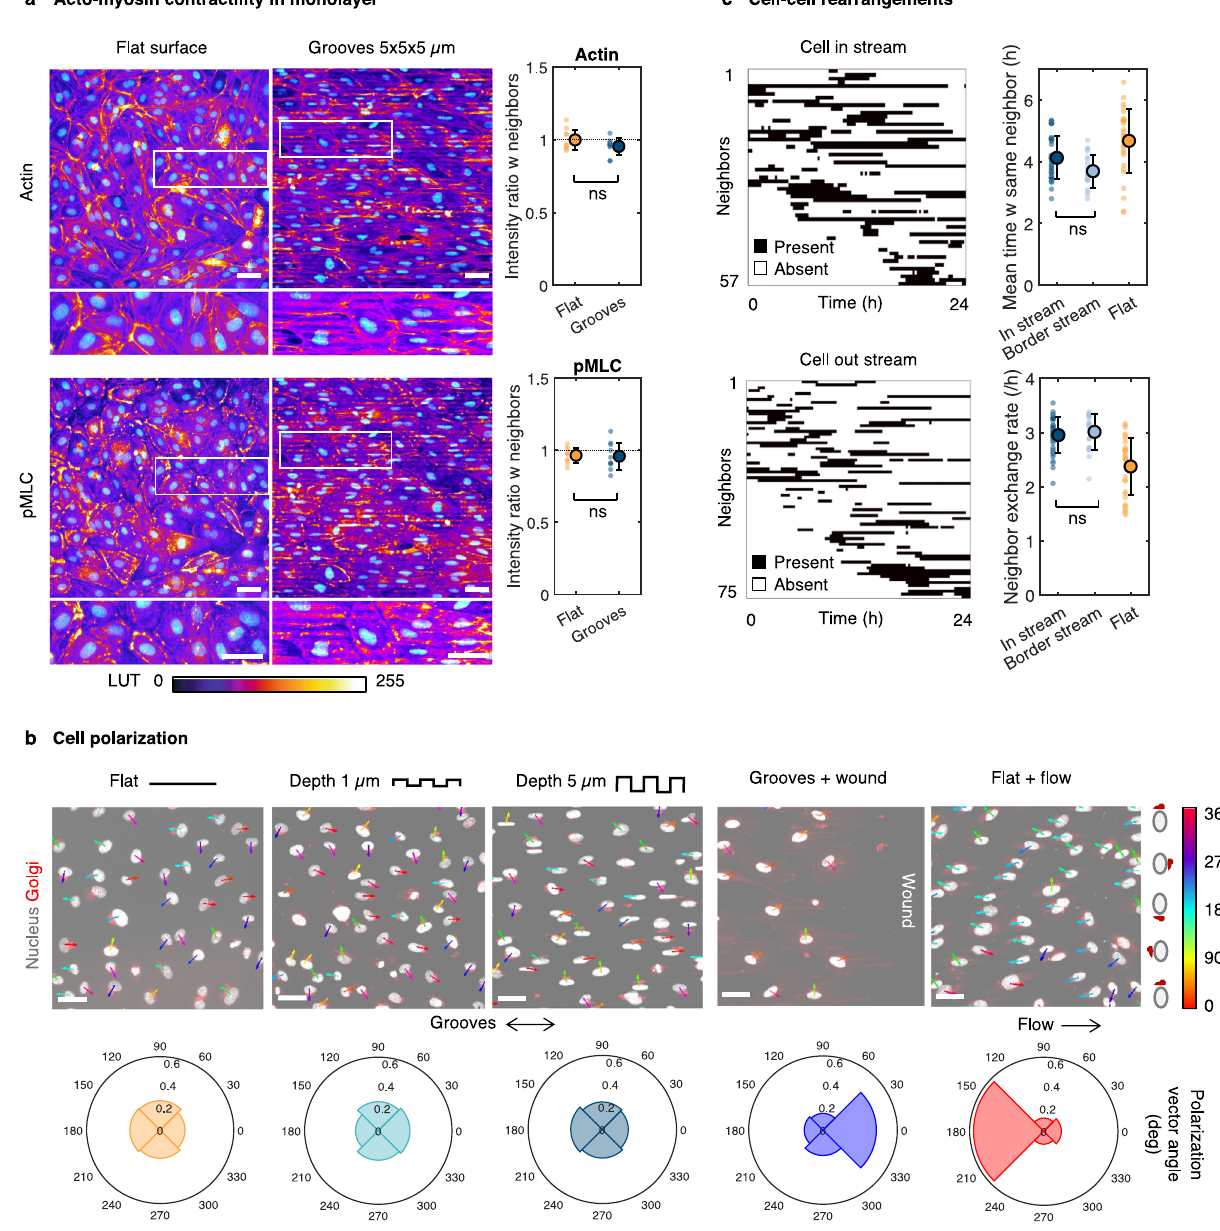
(top) and phospho myosin II light chain (pMLC; bottom), with DAPI in cyan, on a fl at surface or 5 µ m-deep microgrooves. Scale bar 50 µ m. Quanti fi cation shows the ratio between the normalized integrated intensity of fl uorescence in one cell and the mean intensity of its neighbors. N = 10 cells, unpaired t - test. b Cell polarization on fi xed monolayers assessed by immunostaining for TGN46 on a fl at surface, 1- µ m or 5- µ m deep microgrooves, at the edge of a wound perpendicular to 5 µ m-deep grooves, or in HUVECs subjected to steady fl ow (shear stress of 2 Pa) for 24 h on a fl at surface. Polar plots show the distribution of orientations of the nucleus-Golgi vectors. Scale bar 50 µ m. c Dynamics of cell-cell rearrangements quanti fi ed by analyzing the neighbors present within 100 µ m of each cell at each time point. Each black line represents the time during which the same neighbor is present around the considered cell. Quanti fi cation shows the mean time spent with the same neighbor and the neighbor exchange rate (gain or loss of neighbor) for cells on 5 µ m-deep grooves within a stream, at the border between two streams, or on a fl at surface. N = 20 – 30 cells, one-way ANOVA, Tukey ’ s post-test. For all graphs, error bars represent standard deviations. Source data are provided as a Source Data fi